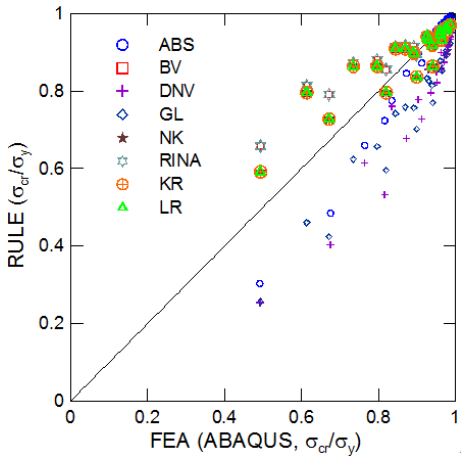
Figure 9. Comparison of the results of buckling strength as per classification rules and finite element analysis [1].